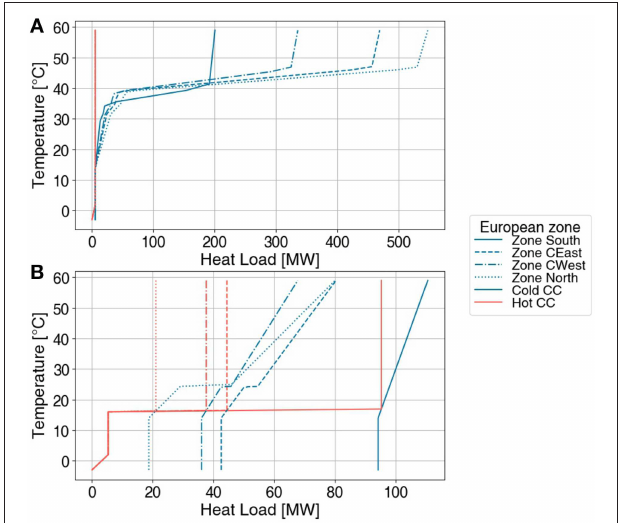
Frontiers in Energy Research |